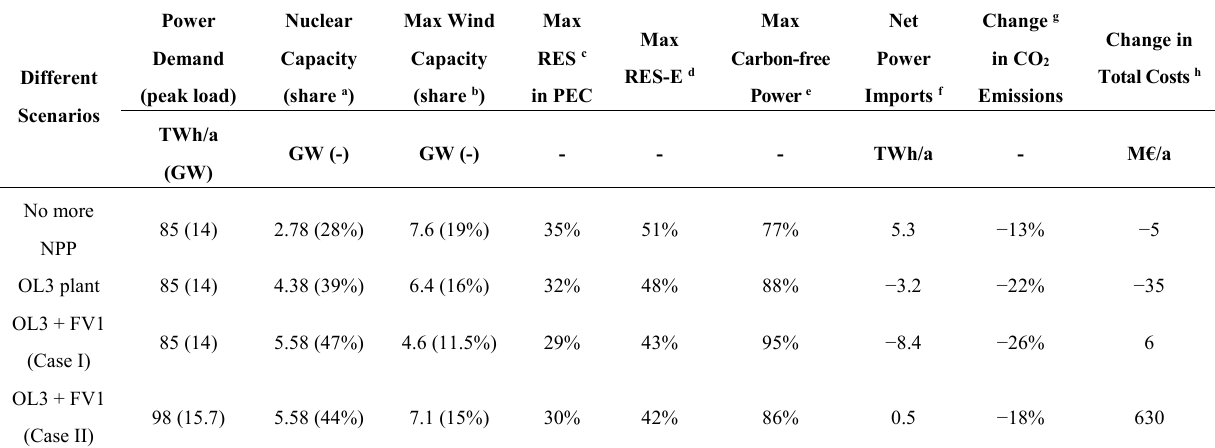
Table C1. The technical, economic, and emission-related implications in different nuclear capacities and the respective maximum possible wind integration, compared to 2012.